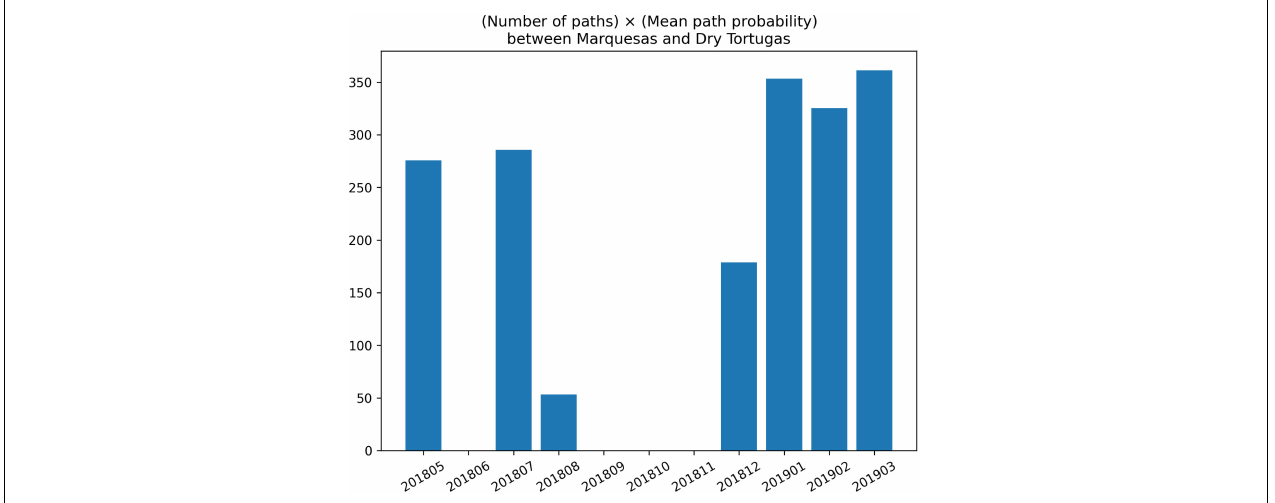
FIGURE A2 | Number of shortest paths from the Marquesas to the Dry Tortugas multiplied by their mean probability for each simulated month with barotropic